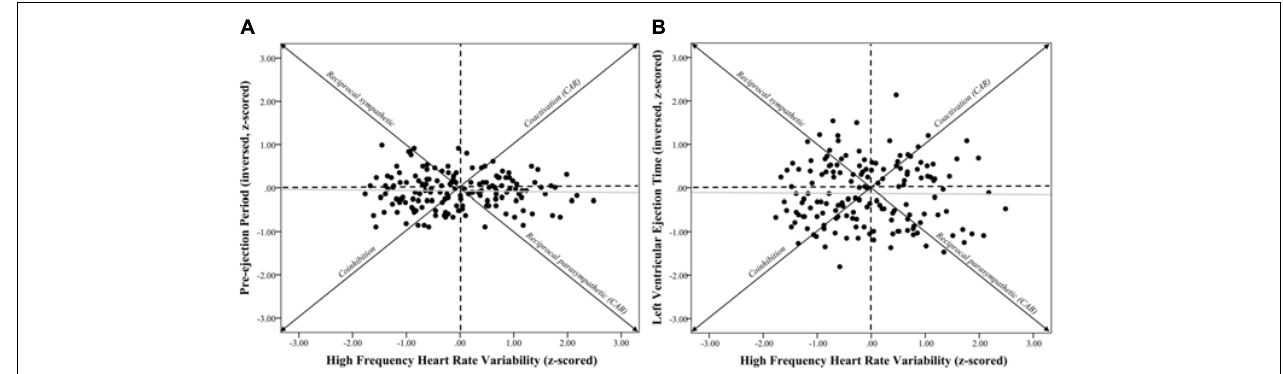
FIGURE 1 | Systolic time intervals and high frequency heart rate variability scatterplots. Note . (A) shows a scatterplot between pre-ejection periods (PEP z -scored and inversed, see section “METHODS” for details) and high frequency heart rate variability (HF-HRV z-scored) ( r = –0.03, p = 0.73). (B) shows a scatterplot between left ventricular ejection time (LVET inversed and z-scored) and HF-HRV ( r = –0.01, p = 0.90). Individuals in the coinhibition quadrant would show lower CAR scores, while individuals in the coactivation quadrant would show higher CAR scores. Individuals in the reciprocal sympathetic quadrant would show lower CAB scores, while individuals in the reciprocal parasympathetic quadrant would show higher CAB